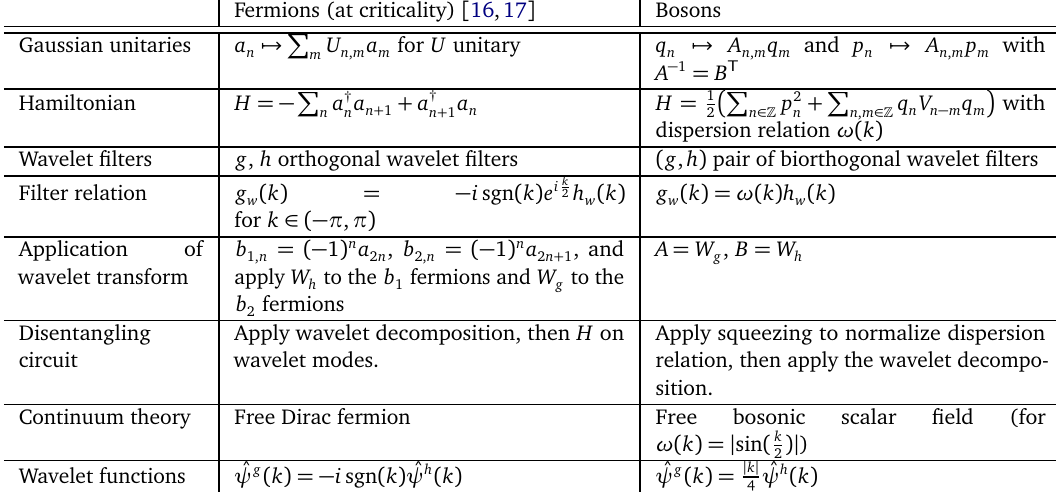
Table 1: Comparison of the wavelet-MERA correspondence for fermions and bosons. Fermions (at criticality) [ 16,17 ]